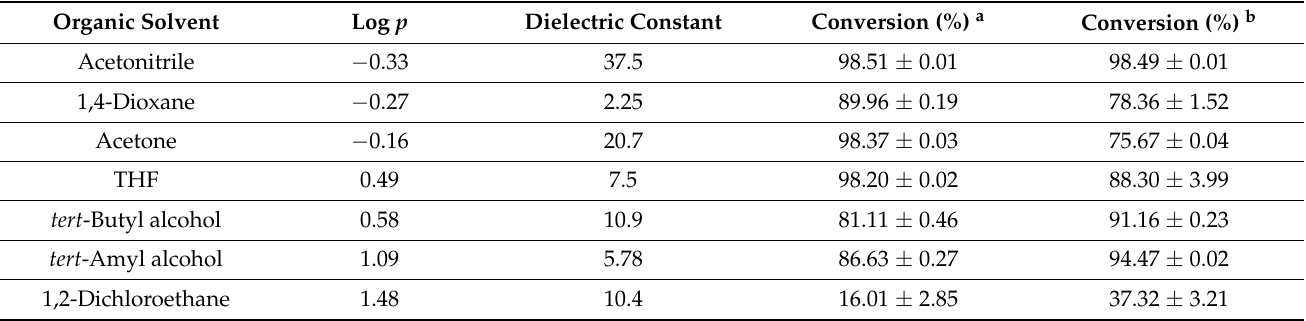
Table 4. Information on organic solvents and the corresponding conversion of naringin